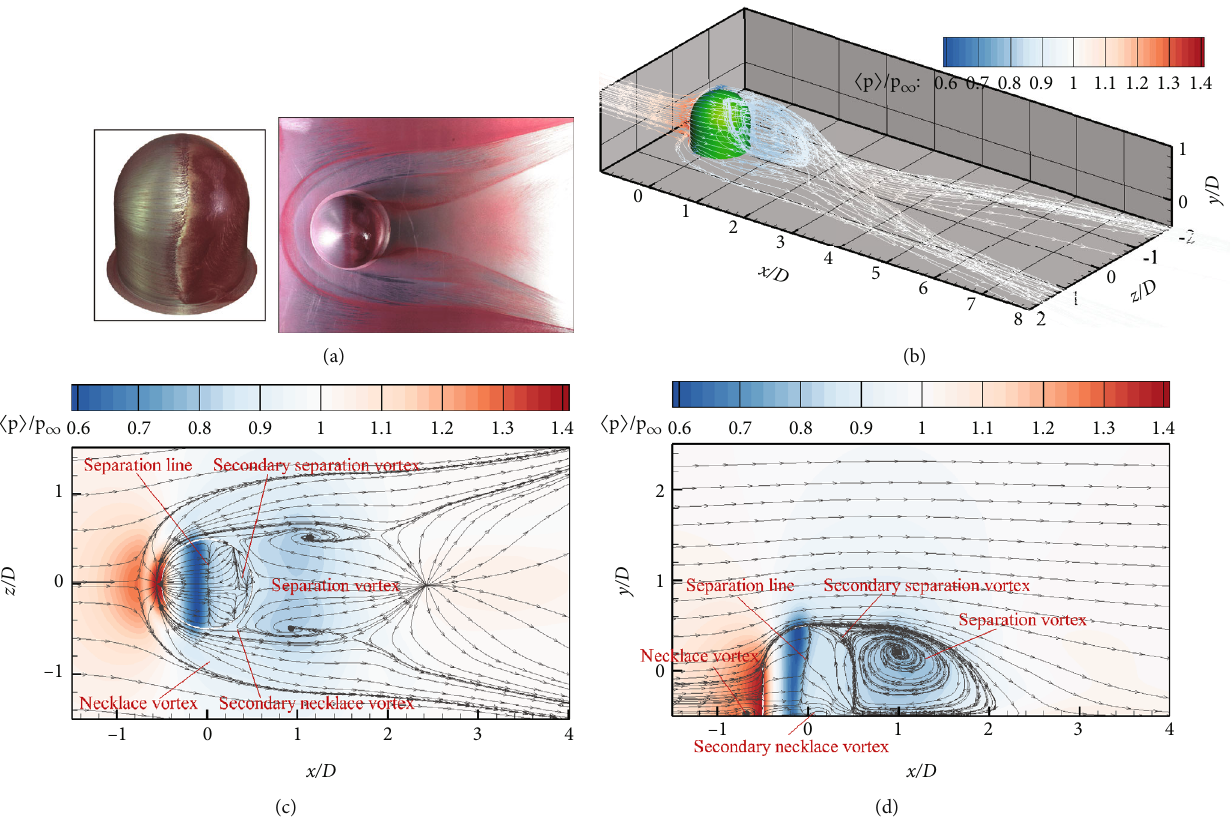
Figure 10: (a) Oil fl ow experiment ( Ma = 0 : 65 ) and streamline distribution based on time-averaged velocity: (b) streamlines in 3D space, (c) streamline mapping near the bottom plate ( y = − 0 : 5 D ), and (d) streamlines along the turret centerline ( z = 0